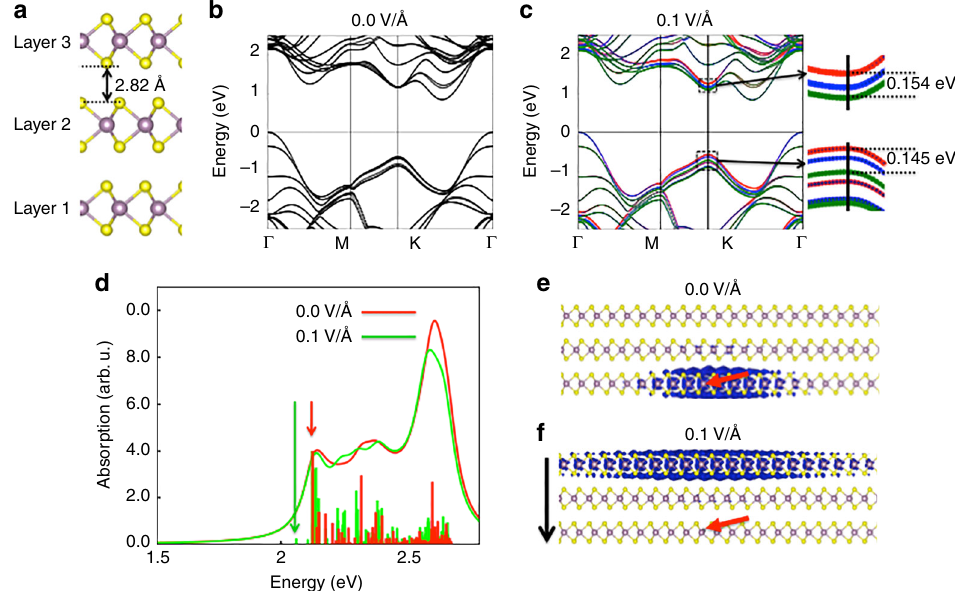
Fig. 5 Modeling of the electronic and optical properties of MoS 2 . a Optimized atomic structure of trilayer MoS 2 . The purple and the yellow balls are Mo and S atoms, respectively. b , c Band structure of trilayer MoS 2 without ( b ) and with ( c ) an electric fi eld. In c , the different colors represent the bands projected onto the three correspondingly labeled layers in a . A separation of the valence and conduction bands as well as the energy difference between them at K are shown as a zoom-in inset in c . d Calculated absorption spectra with (green) and without (red) an electric fi eld. Positions of the relevant intra- and inter- layer excitonic peaks are marked with vertical lines. e , f Excitonic wave functions of the fi rst excitonic peak (intra-layer exciton) in the absorption spectrum without the electric fi eld ( e ) and of the fi rst excitonic peak (inter-layer exciton) in the presence of the electric fi eld ( f ). The direction of the electric fi eld is shown with a vertical black arrow. In e and f , the electron density is plotted for the case when the hole (marked by a small red arrow) is localized in layer 1 close to Mo